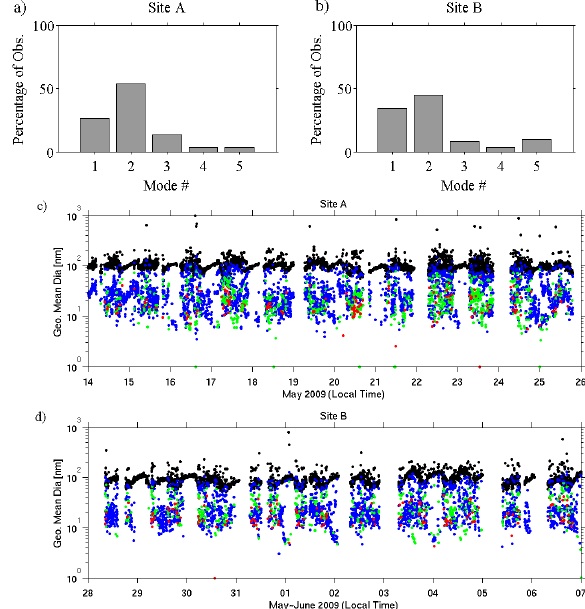
Fig. 6. (a–b) Modal distribution for dry aerosol size distribution. Figure 6: a-b):Modal distribution for dry aerosol size distribution. Multi-lognormal distribution was used Multi-lognormal distribution was used to fit the observed spectra to fit the observed spectra and a 2 χ test was used to choose the distribution with lowest number of and a χ 2 test was used to choose the distribution with lowest num- modes with alpha=0.05. c-d)Time evolution of fitted lognormal modes (geometric mean diameter of each ber of modes with α = 0 . 05. (c–d) Time evolution of fitted lognor- mode). mal modes (geometric mean diameter of each